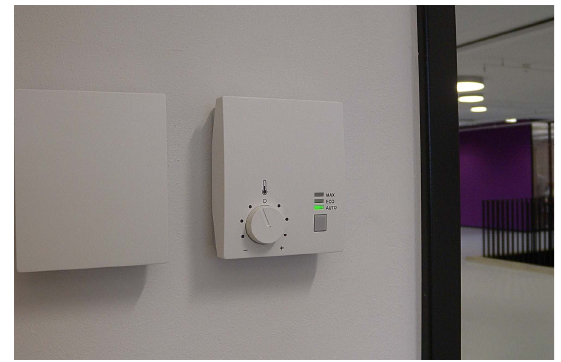
Figure 7. User interface and box with air temperature